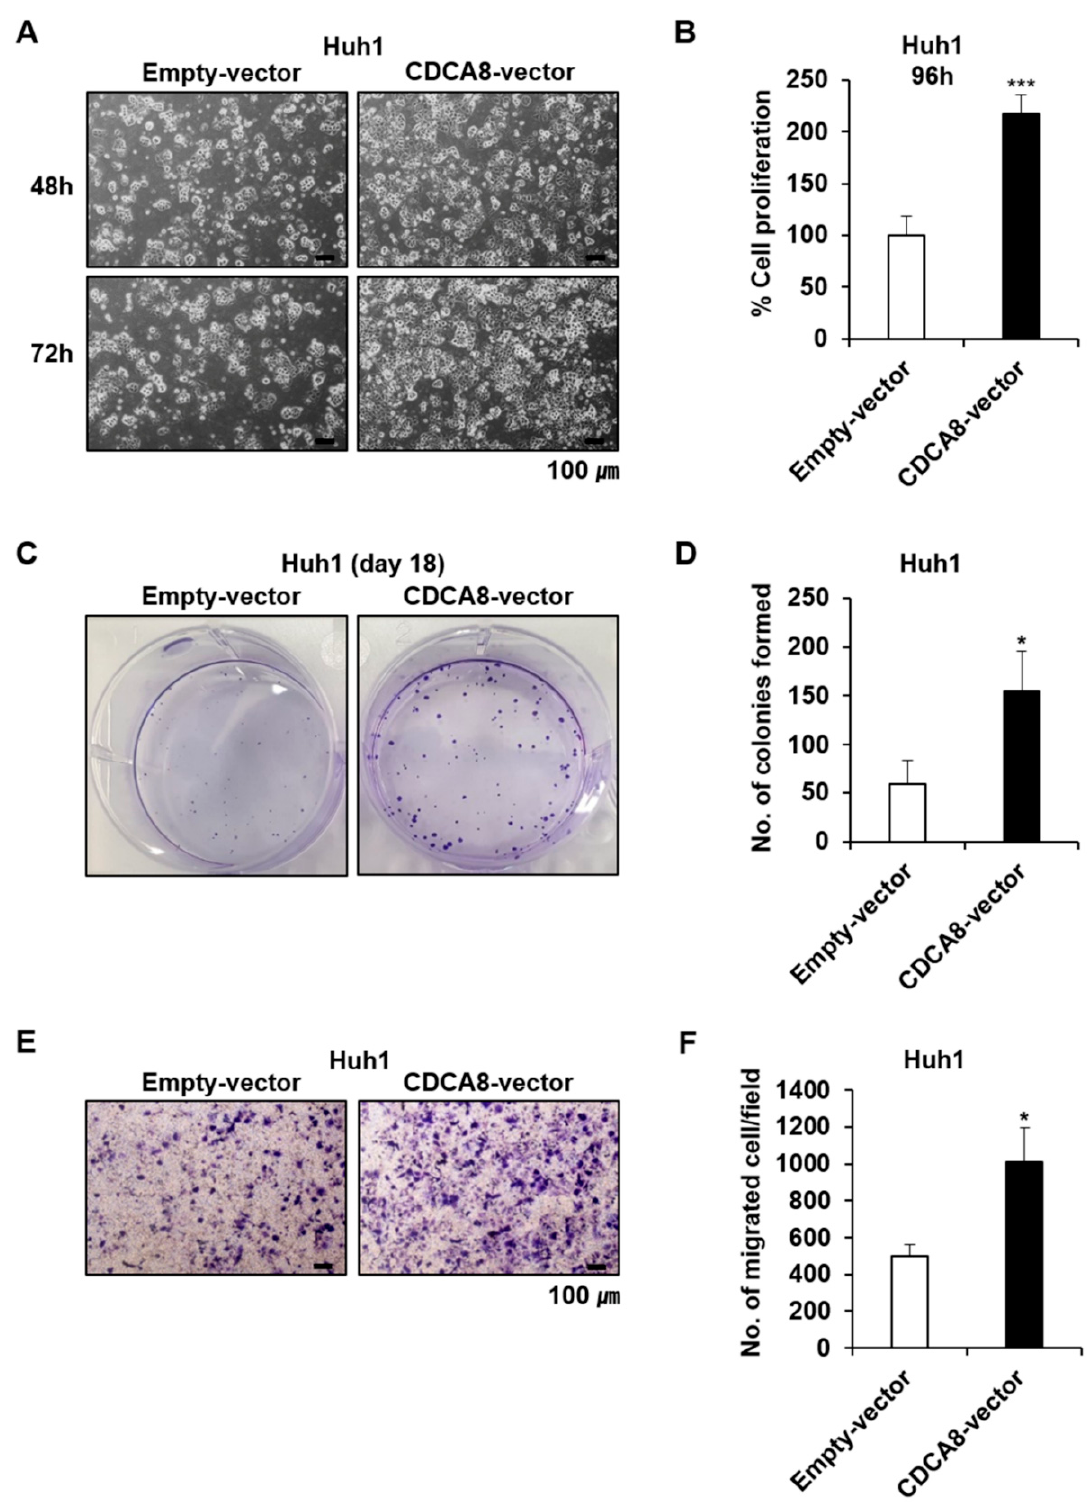
Figure 4. CDCA8 promotes proliferation and migration of CRC cells. ( A , B ) Representative light microscopy images ( A ) and the number of proliferative Huh1 cells ( B ) transfected with empty control vector or CDCA8-overexpressing vector for 96 h. ( C , D ) Observation of changes in the clonogenicity ( C ) and the number of colonies ( D ) after 18 days of the indicated treatments. ( E , F ) Representative light microscopy images ( E ) and the number of migratory Huh1 cells ( F ) transfected with empty control vector or CDCA8-overexpressing vector. Empty-vector, transfected with empty control vector; CDCA8-vector, transfected with CDCA8-expressing vector. * p < 0.05; *** p < 0.001 vs. control.